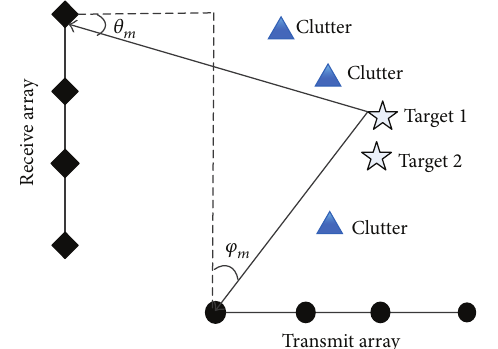
Figure 1: Two closely spaced targets imbedded in three clutter